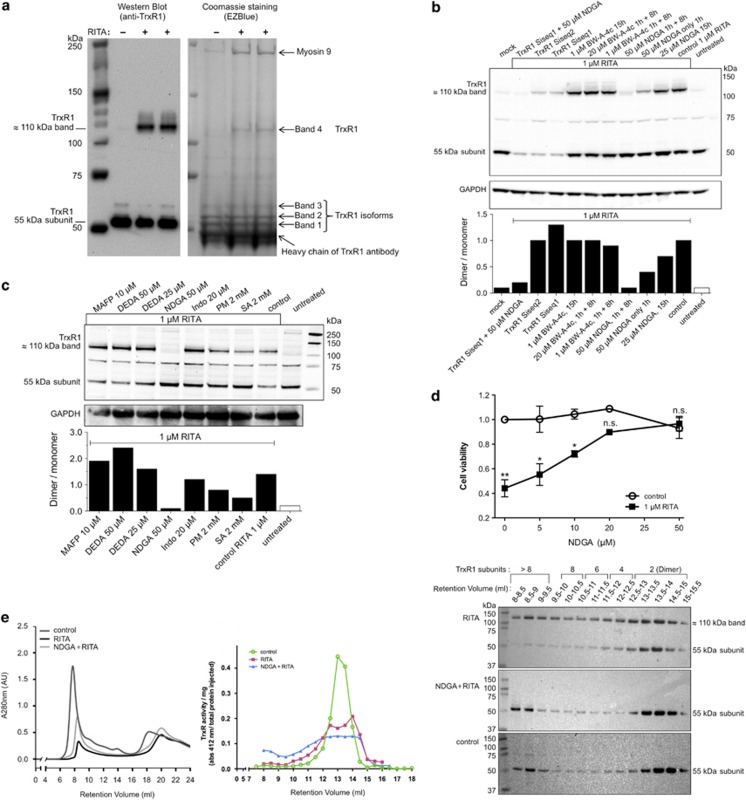
RITA treatment promotes the formation of covalently linked TrxR1 oligomers in cancer cells that can be prevented by NDGA and correlate with cell death. (a) RITA (1 μM) treatment of HCT116 cells for 8 h triggers the formation of an ≈110 kDa TrxR1-positive band seen in western blots.13 Here TrxR1-derived protein species were enriched from HCT116 cells (controls or treated with RITA, as indicated) by immunoprecipitation, visualized by Coomassie staining and further analyzed by tryptic digests and mass spectrometry (Supplementary Table S1). (b, c) Pre-treatment of HCT116 cells using 50 μM NDGA for 1 h blocked RITA-induced formation of TrxR1 dimeric bands as seen on western blots, also further verified using knockdown of TrxR1 with siRNA (Siseq1 and Siseq2). Below the western blots, the results of densitometric quantifications of dimer over monomer ratios are shown. See text for details. DEDA, 7,7-dimethyl-(5Z,8Z)-eicosadienoic acid 25 or 50 μM (phospholipase A2 inhibitor, sPLA2 and cPLA2); Indo, indomethacin 20 μM (Cox 1, 2 inhibitor); MAFP, methyl arachidonyl fluorophosphonate 10 μM (phospholipase A2 inhibitor, cPLA2 and iPLA2); NDGA, nordihydroguareric acid 50 μM; PM, pyridoxamine dihydrochloride 2 mM; SA, salicylamine 2 mM (to scavenge lipid-derived ketoaldehydes). (d) NDGA treatment prevents RITA-induced cell death in HCT116 cells. (e) TrxR1 oligomers in cell lysates, as indicated, were fractionated using gel filtration (left), whereupon all fractions were analyzed for TrxR activity (middle) and band sizes as detected using western blot of reducing SDS-PAGE analyses (right). The expected migration over the gel filtration column of different TrxR1 oligomers in solution is also indicated as the number of TrxR1 subunits that would be required to yield the corresponding elution (top, right panel)